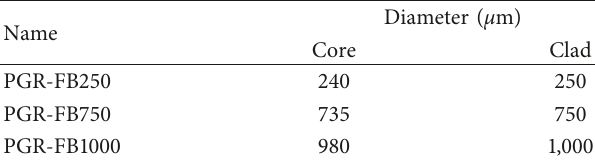
Table 2: Detailed dimensions of three types of POF